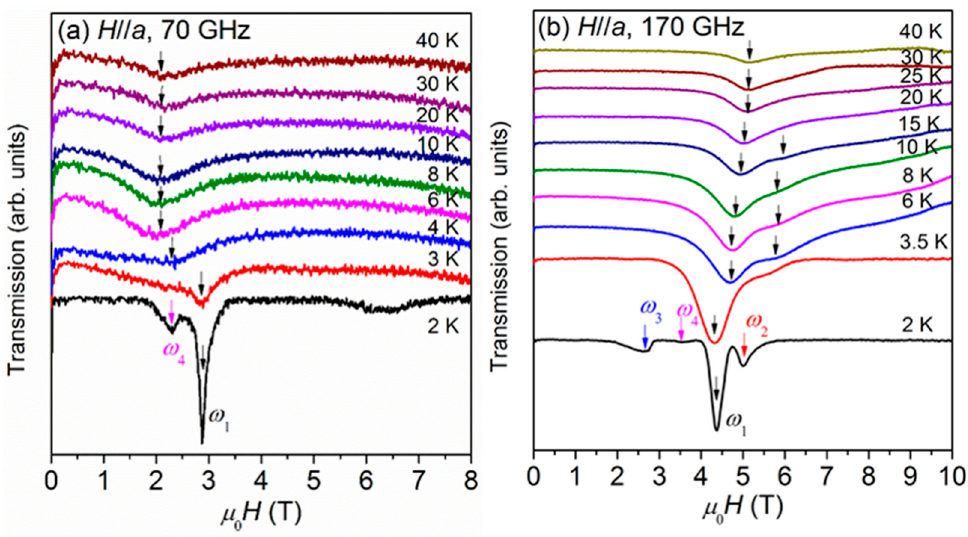
Figure 2. Temperature-dependent ESR spectra measured at 70 GHz ( a ) and 170 GHz ( b ) along the easy a axis.